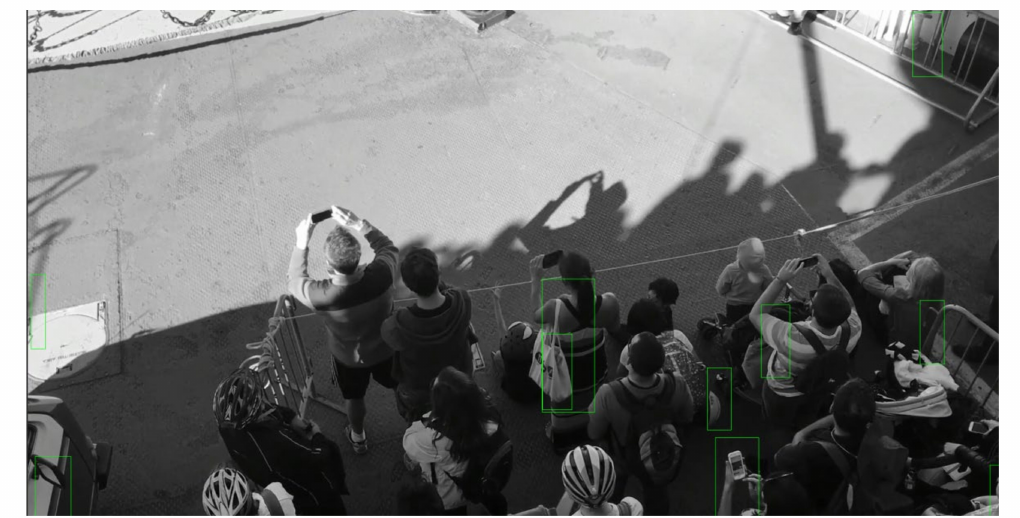
Figure 3. Screenshot of video stream being analyzed by the Python script and its division into labeled cells.